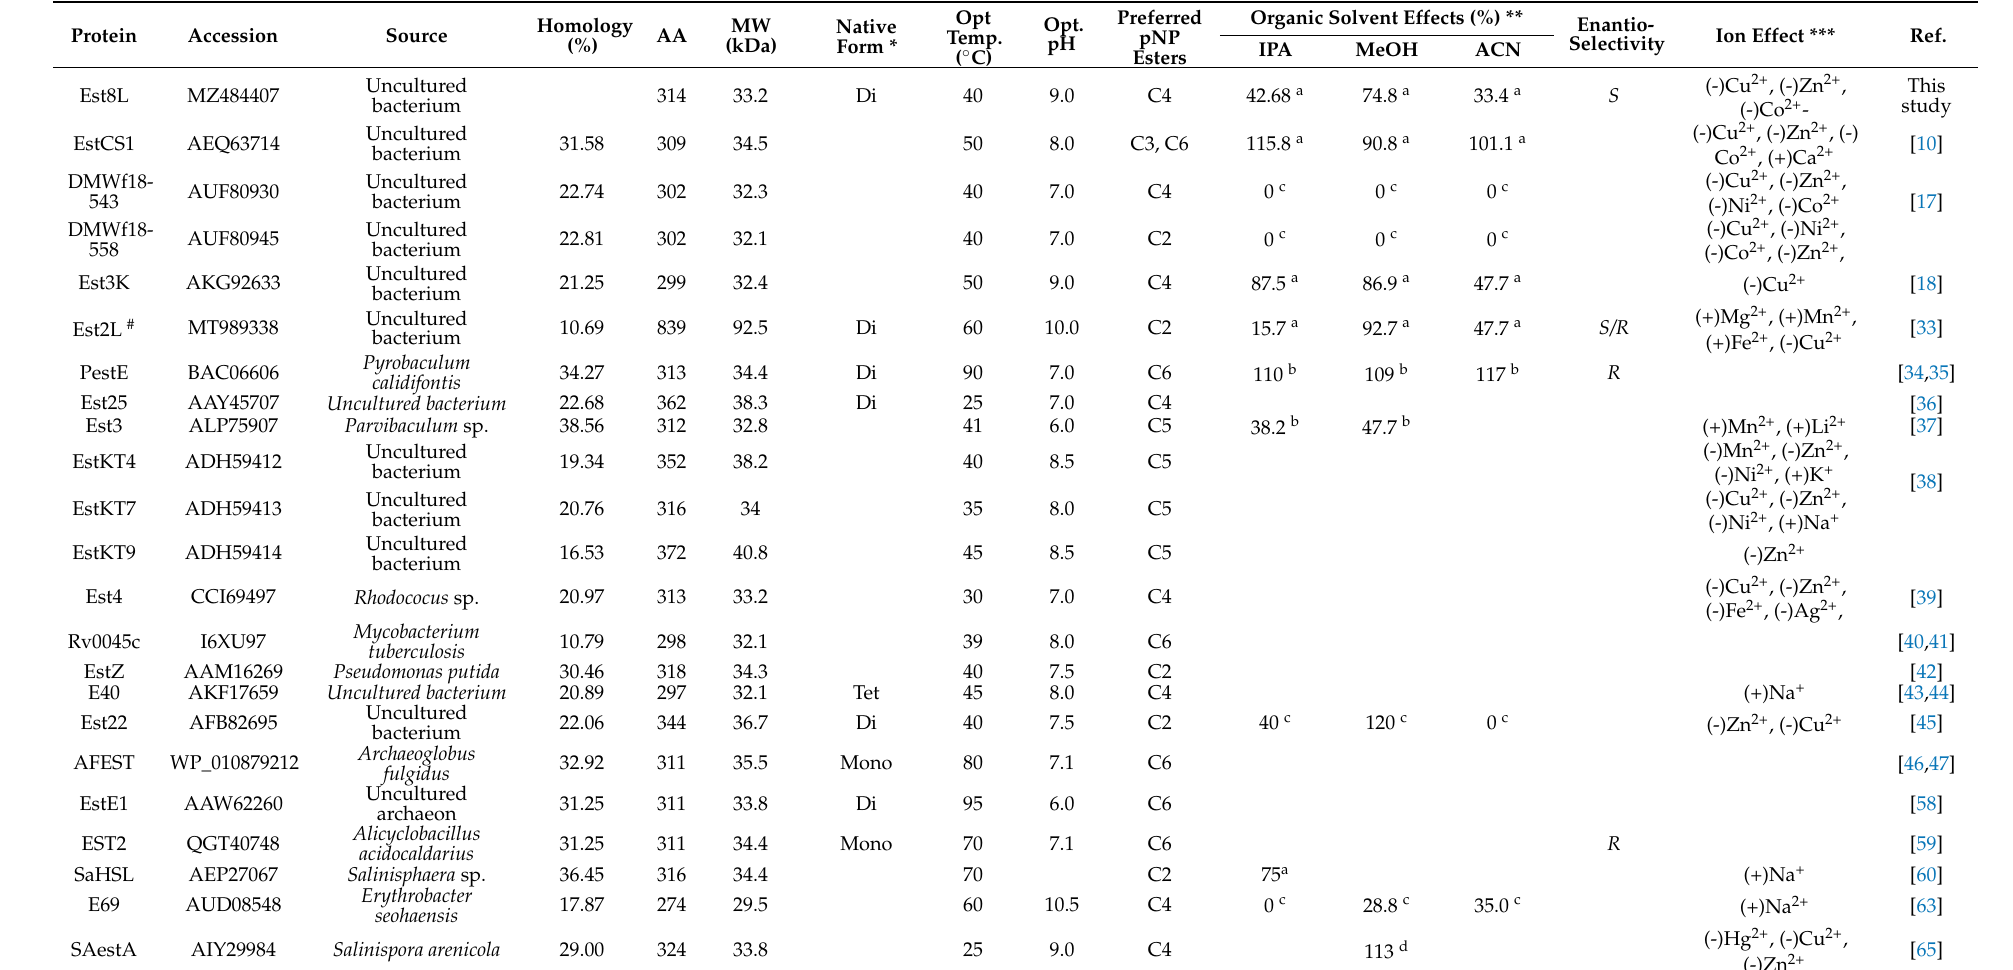
Table 3. Comparison of Est8L and other bacterial hormone-sensitive lipases